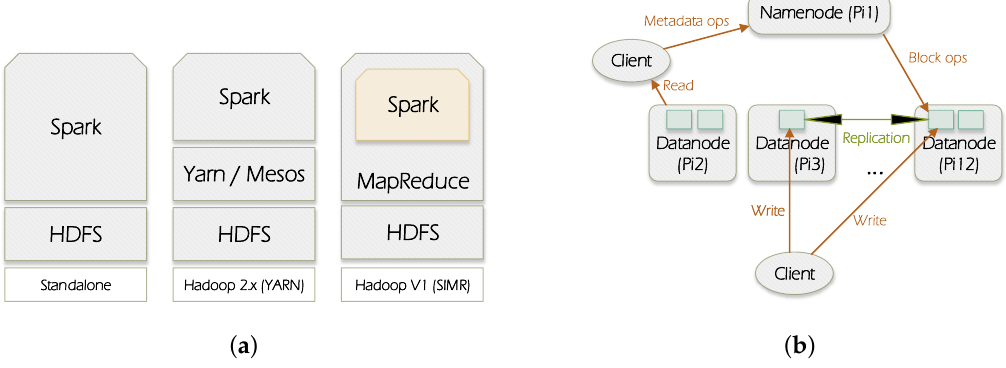
Figure 1. Spark and HDFS (Hadoop Distributed File System) overview. ( a ) Spark deployment; ( b ) HDFS